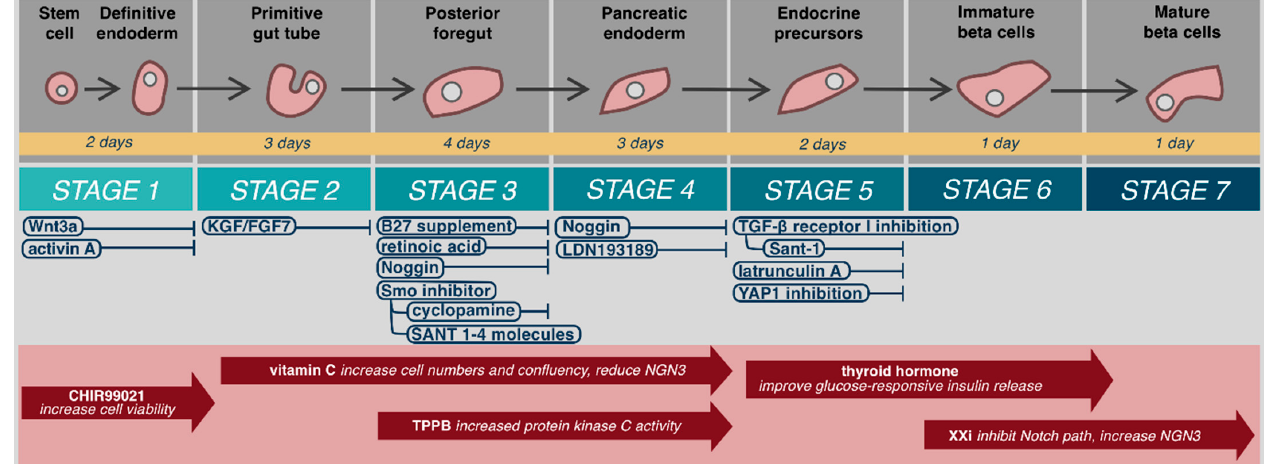
Figure 1. Embryological differentiation and maturation of islet cells.